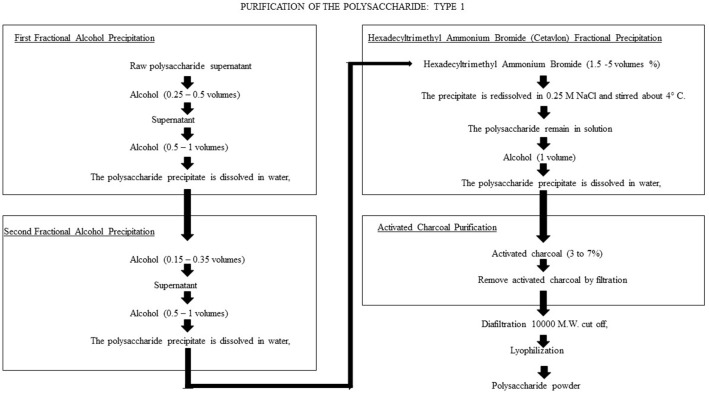
Flow diagram for the CPS type-1 purification process proposed by Cano et al. (1979). The purification method includes ethanol precipitation, hexadecyltrimethylammonium bromide (Cetavlon) precipitation and purification by activated charcoal. The process removed more than 99% of contaminant protein, nucleic acid and C-carbohydrates while retaining the immunogenicity of the product.